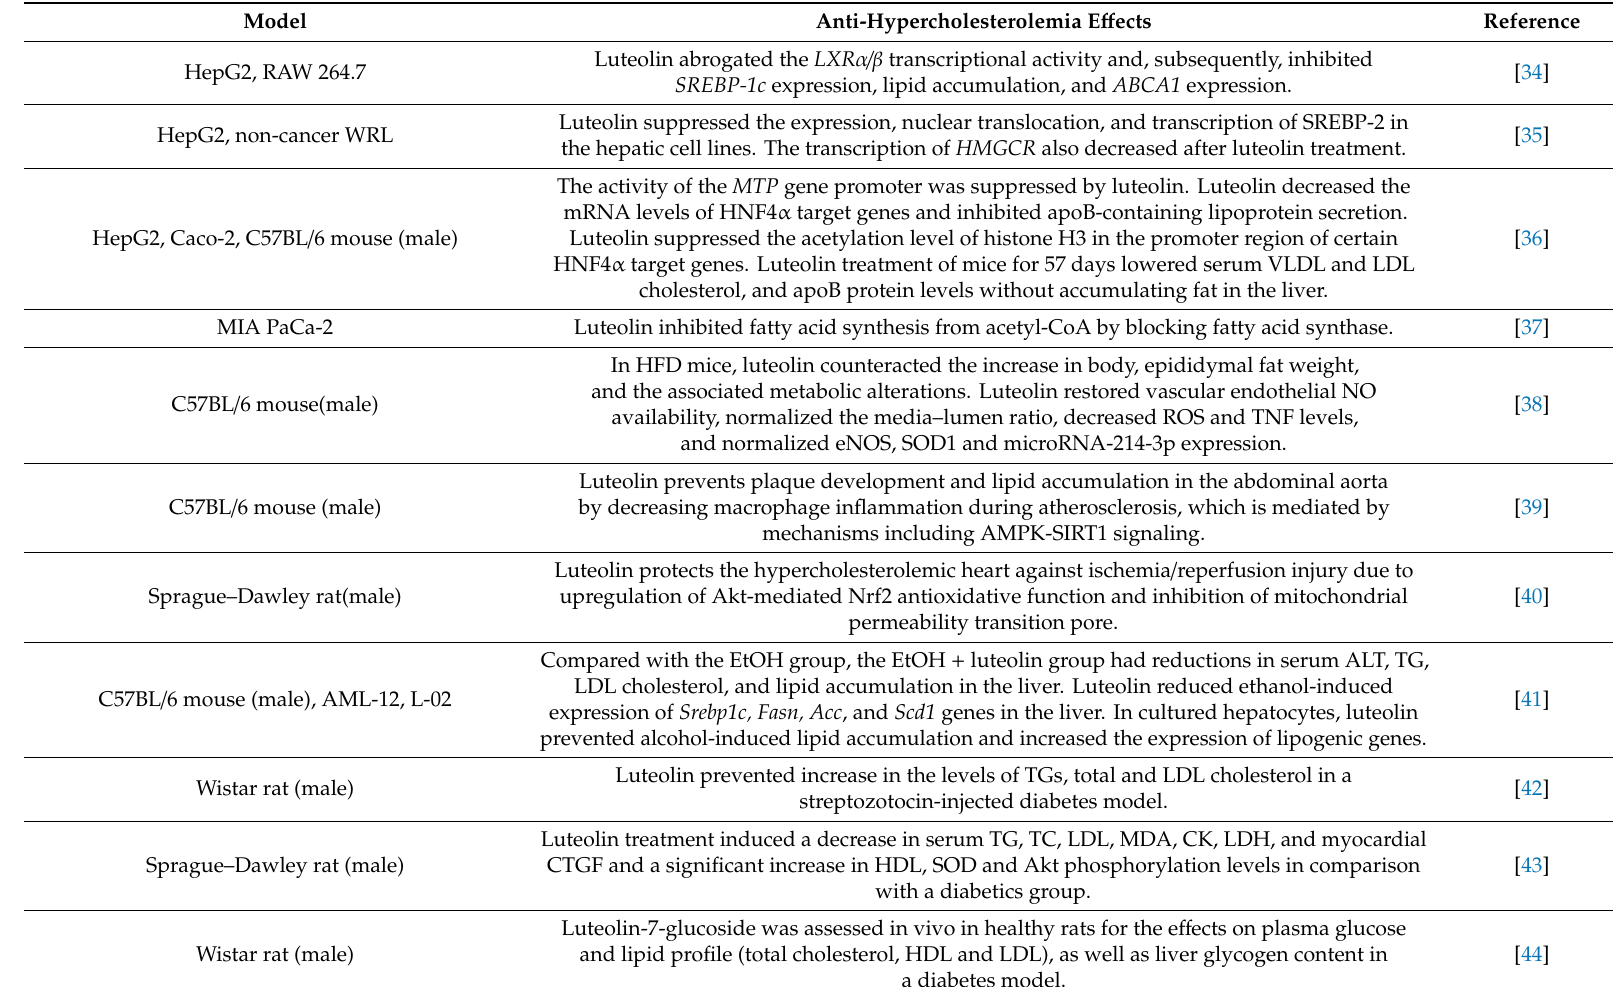
Table 2. The e ff ect of luteolin on hypercholesterolemia, independent of the e ff ect on